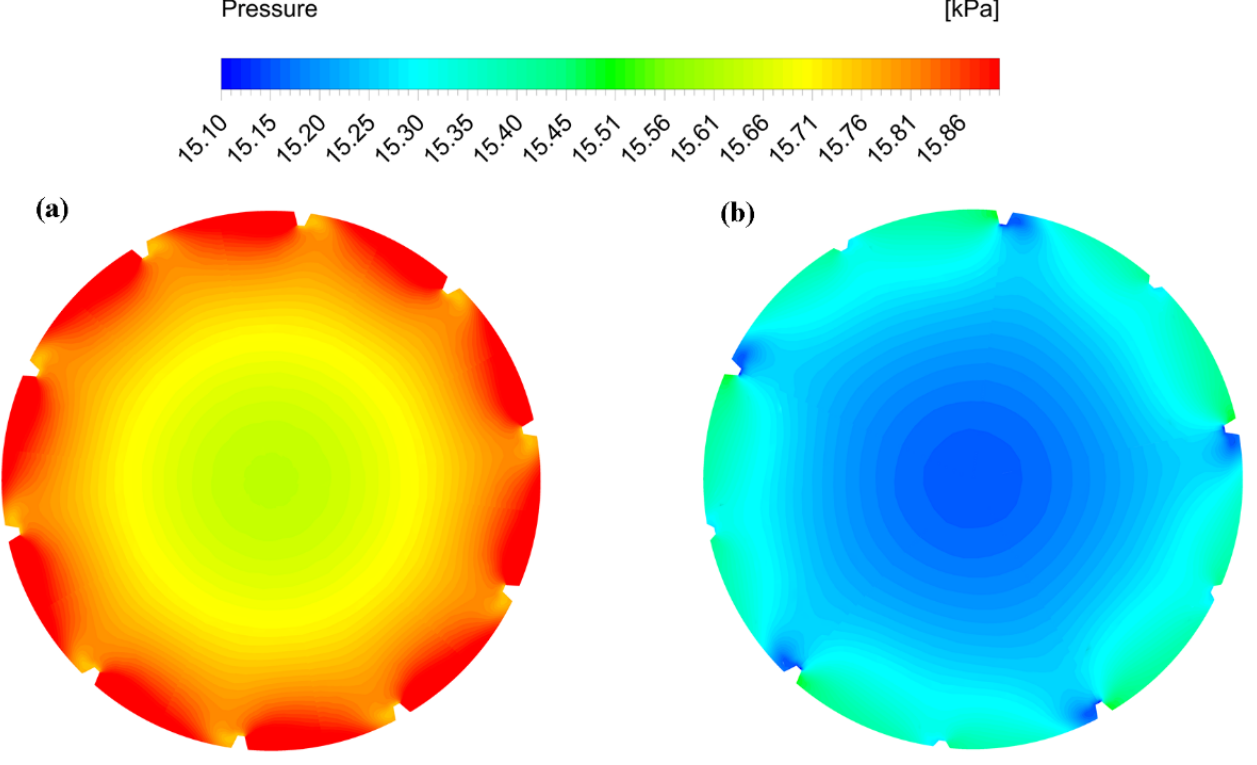
Figure 10. Turbulence kinetic energy contours at Re 54,000 for ( a ) Equal fin height; ( b ) Alternating fin height. Figure 11 shows the relative thermal and hydraulic performance of studied